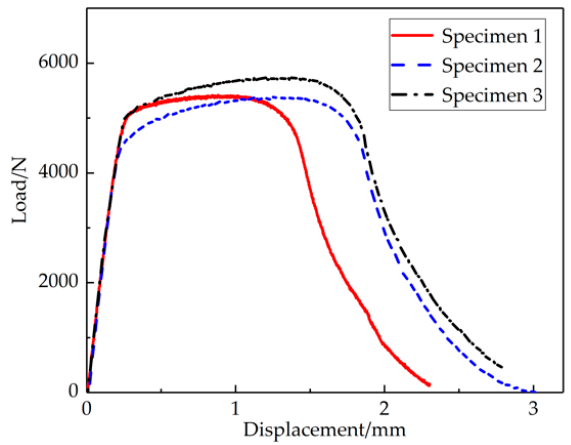
Figure 4. The load–displacement (L-D) curve of the tensile test of the three joints. Table 3. The tensile test results.